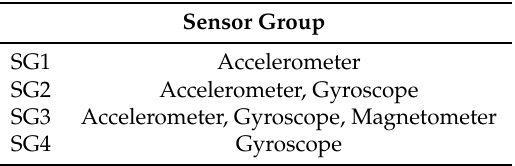
Table 9. Sensors arrangement for evaluating scenario A .